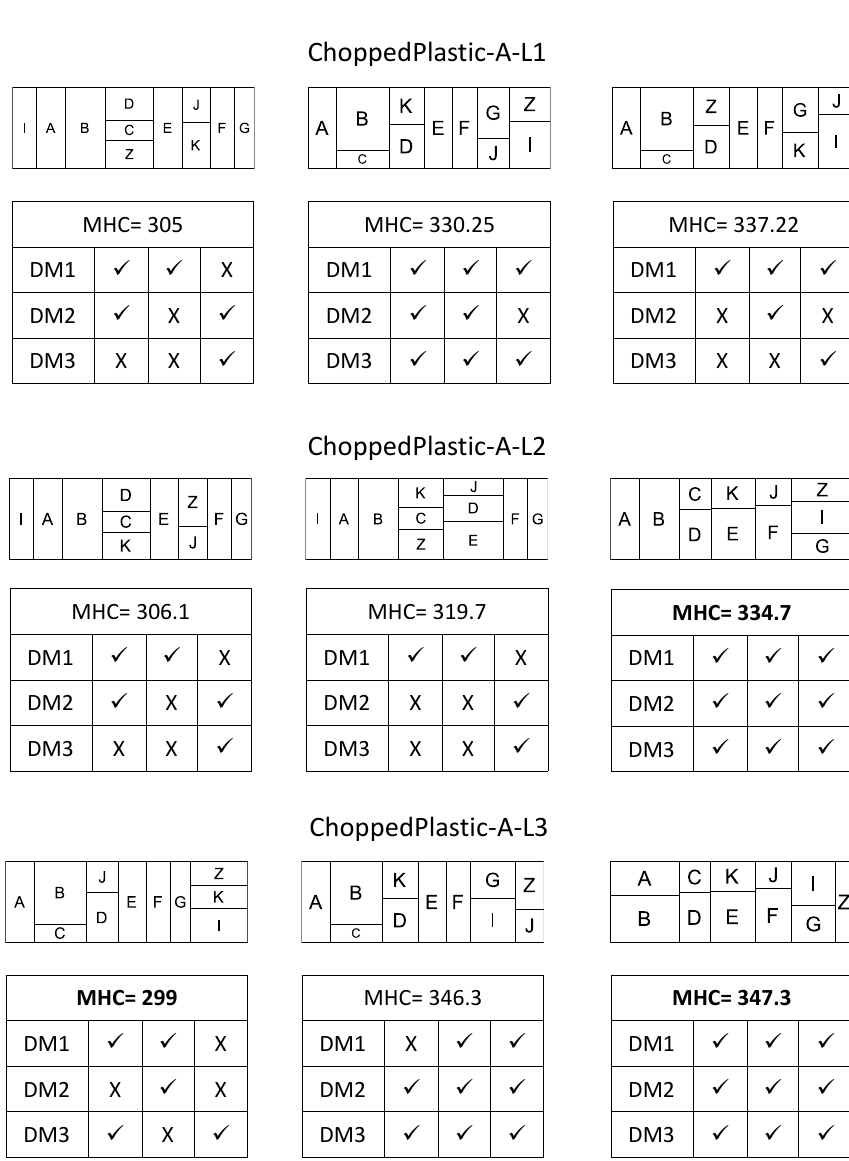
Figure 15. Best solutions found in Alternative launch 1 to 3 of ChoppedPlastic